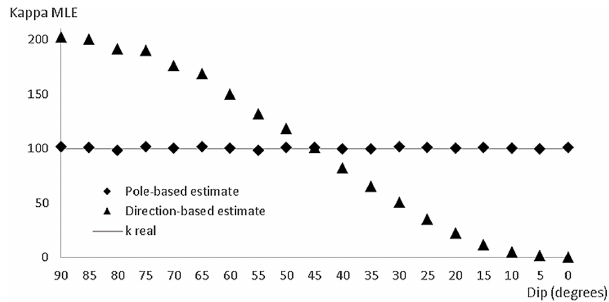
Figure 6. Distortion of the maximum likelihood estimation (MLE) of concentration or spherical variance of 100 spherical unit vector samples of a size of 1000 individuals drawn from a von Mises– Fisher distribution with κ = 100. A pole-based estimate is always consistent with the data while dip-based ones either over- or under- estimate